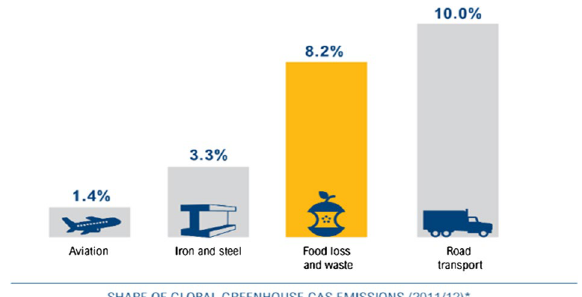
Fig. 16 Greenhouse emission from food loss and waste (FAO